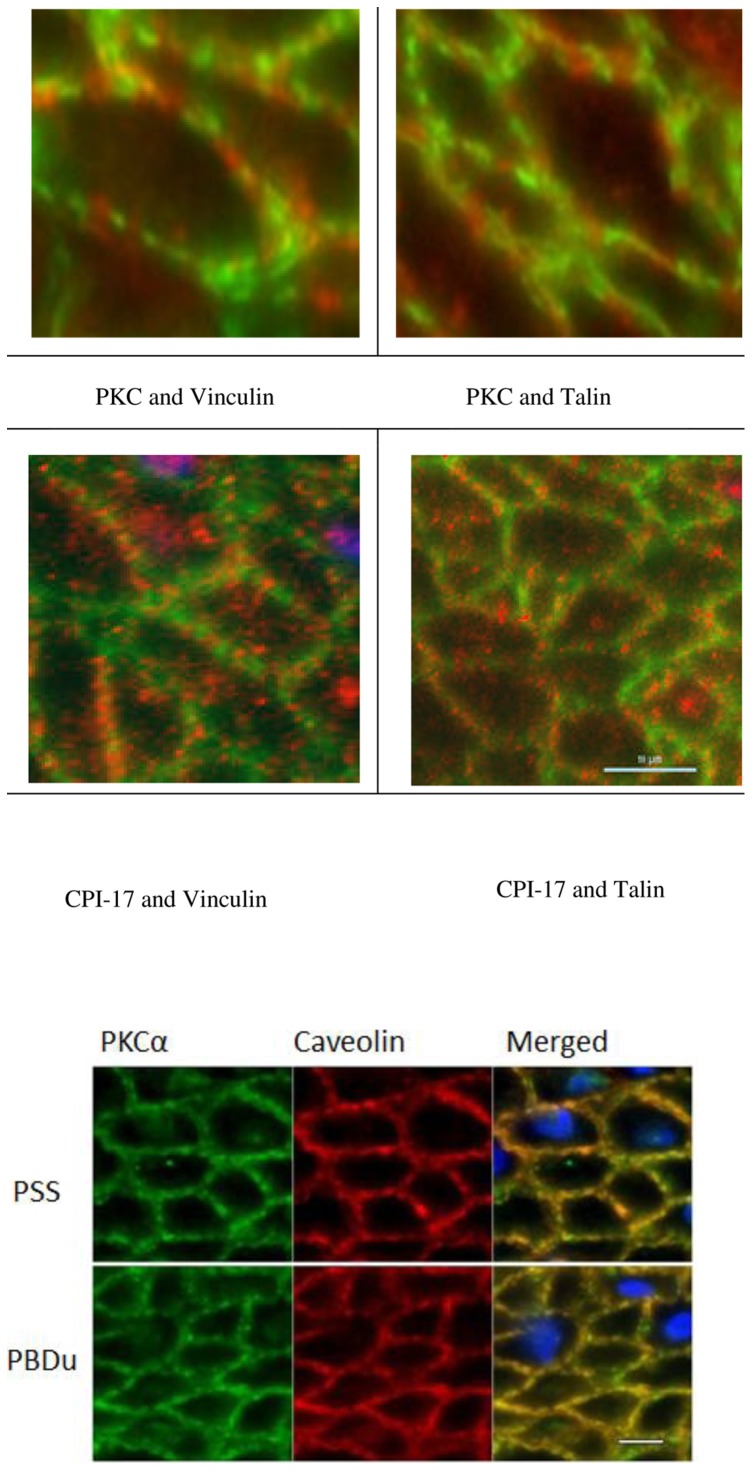
Confocal images of pig fundus (upper panel) in relaxed condition (top row) and with PDBu (30′) stimulation (lower row).Double labeling for PKCα (green) with vinculin (red, upper left) or talin (red, upper right) or CPI-17 (green) with vinculin (red, lower left) or talin (red, lower right). Vinculin and talin are adherens junction associated proteins that appear to have an alternating distribution with PKC and CPI-17, suggesting that these proteins are not localized to the same domains near the plasma membrane. Note that not all of the PKCα or CPI-17 is located near the plasma membrane. Lower panel - Relaxed (PSS – upper row) and activated (PDBu – lower row) pig antrum tissue reacted with PKCα (left column, green) and caveolin (middle column, red) and merged with nuclei (right column, PKCα – green; caveolin – red; DAPI – blue). Co-localization of PKCα and caveolin result in yellow/orange fluorescence. Scale bar = 10 µm.